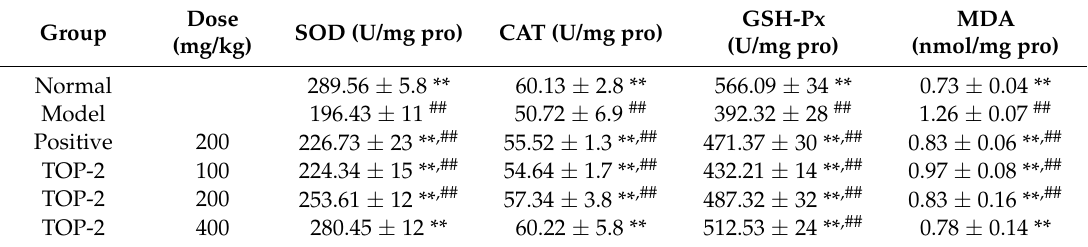
Table 4. Effects of TOP-2 on liver SOD, CAT, GSH-Px activities and MDA levels in alcohol-induced liver injury